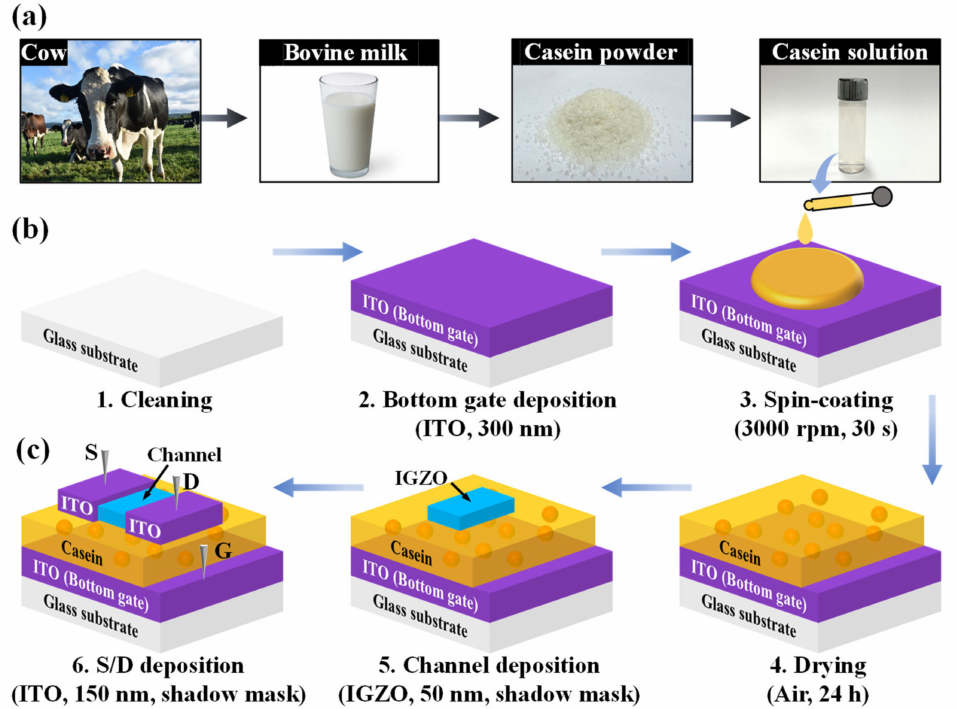
Figure 1. ( a ) Schematic of casein solution preparation. ( b ) Fabrication details and ( c ) schematics of casein electrolyte-based electric-double-layer (EDL) synaptic transistors on glass